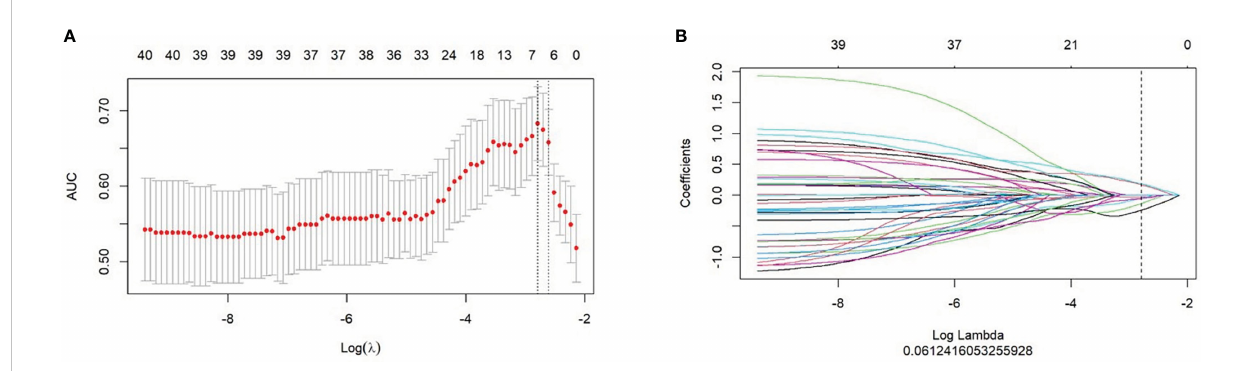
FIGURE 1 Selection of radiomics features for predicting response using the least absolute shrinkage and selection operator (LASSO) logistic regression model. (A) LASSO coef fi cient pro fi les of the radiomics features. (B) The cross-validation curve.